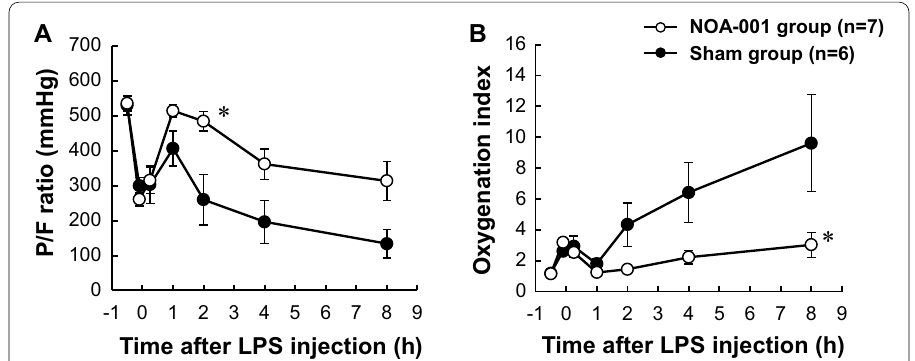
Fig. 3 Changes in pulmonary gas exchange parameters. a P / F ratio and b oxygenation index. Data are shown as mean SEM. * p < 0.05 for NOA-001 vs. sham by two way ANOVA with a Tukey post hoc ±